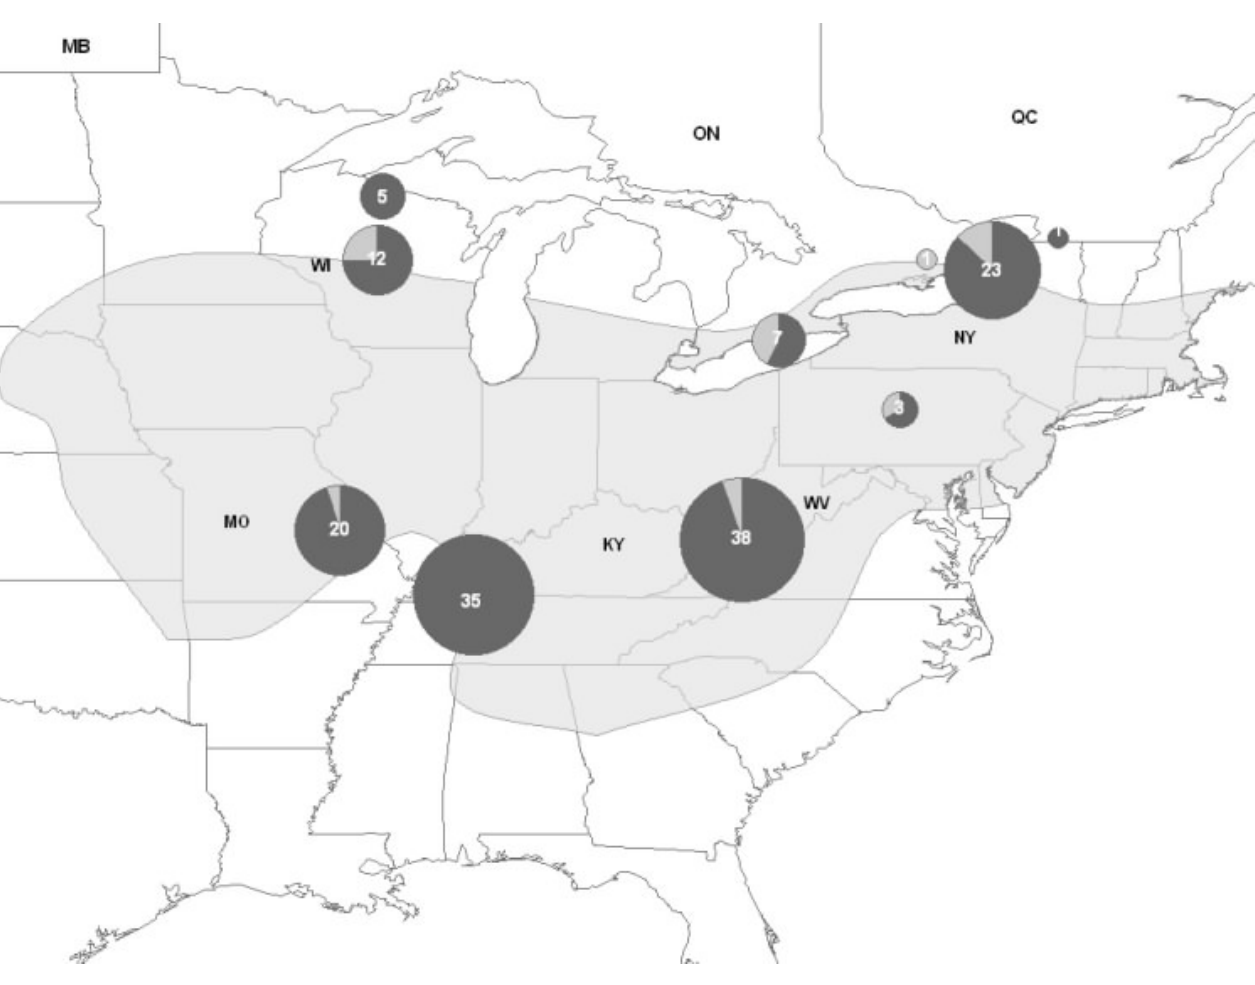
Fig. 2 . A map of northeastern North America indicating the Blue-winged Warbler breeding range (shaded area). The dark sections of the pie charts in each state/province indicate the proportion of Blue- winged Warbler samples that were assigned to the ancestral Blue-winged Warbler haplotype group; the lighter grey areas represent the proportion of Blue-winged Warbler samples assigned to the Golden- winged Warbler haplotype group. Numbers within pie charts represent the number of Blue-winged Warblers that were sampled per state/province. MB stands for Manitoba; ON, Ontario; QC, Quebec; WI, Wisconsin; NY, New York; MO, Missouri; KY, Kentucky; and WV, West